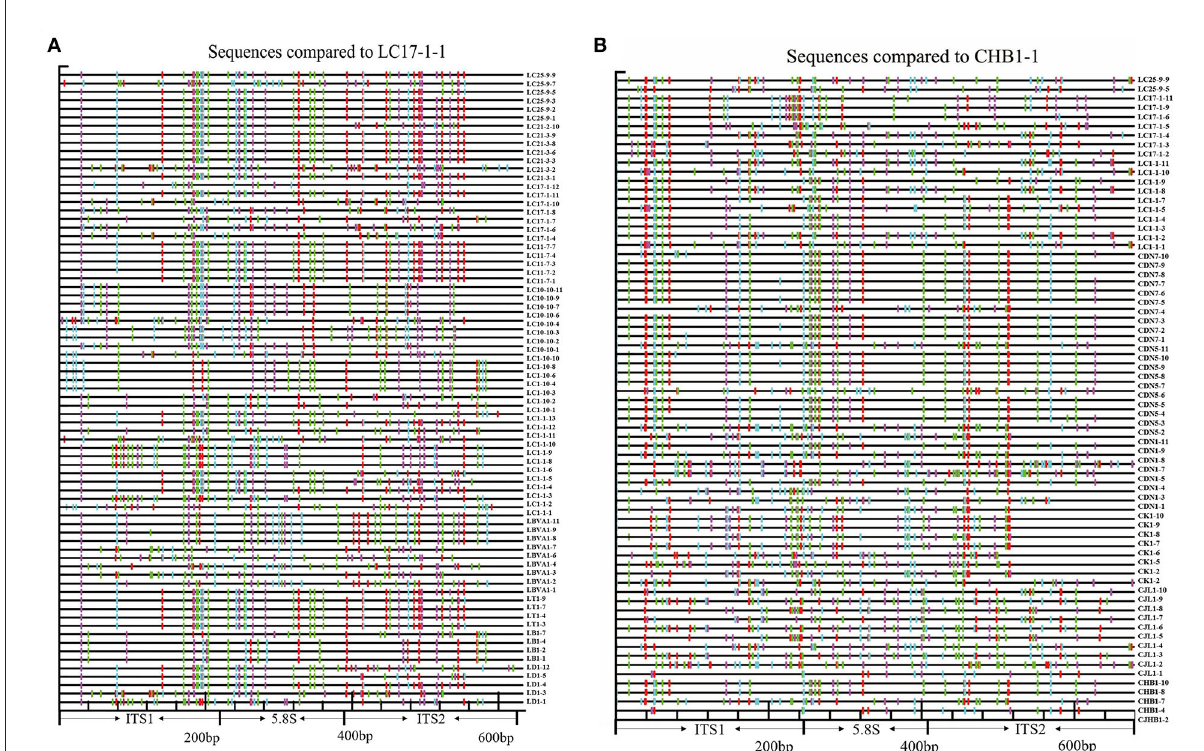
FIGURE2 Schematic illustration of the distribution of substitution sites across the entire ITS region. (A) Assumed pseudogenes (excluding sequences obtained via direct sequencing) were yielded by primers ITS1-ITS4 using the putative functional sequence from LC17-1-1 as a reference. (B) Putative functional copies and cDNA paralogues from primers P1-P2 using CHB1-1 as a reference (red = GG > AG, cyan = GA > AA, green = GC > AC, magenta = GT > AT, black = not a G > A transition, yellow = gap) (For interpretation of the references to color in this figure legend, the reader is referred to the web version of this